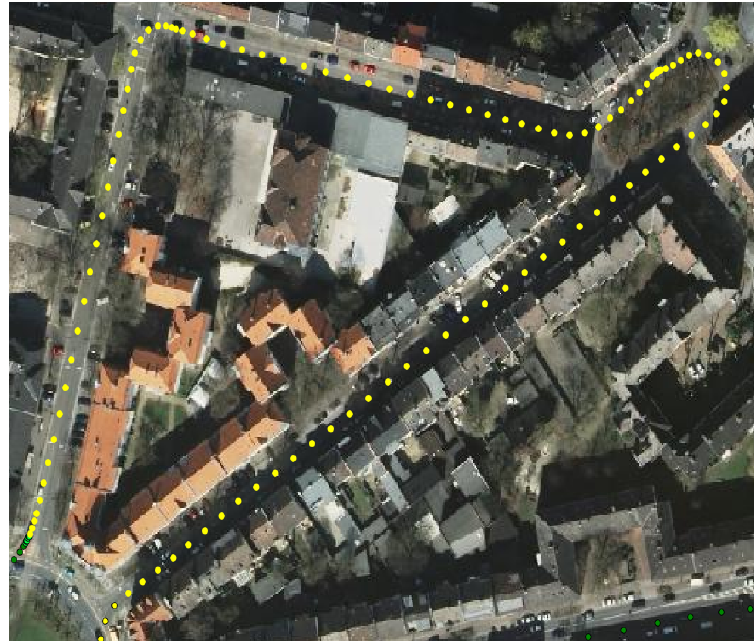
Figure 7. Path segment with close buildings and